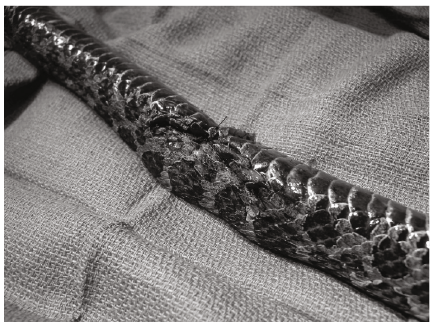
Figure 4: Massasauga rattlesnake ( Sistrurus catenatus ). Intraoperative photograph taken after extraction of two self-in fl ating hygroscopic tissue expanders. The excess expanded skin is visible on the near side of the incision. There is a thin band of soft tissue between the two implant sites (arrow). The ventral surface of the neoplasm is displacing the ventral scales (arrowhead).